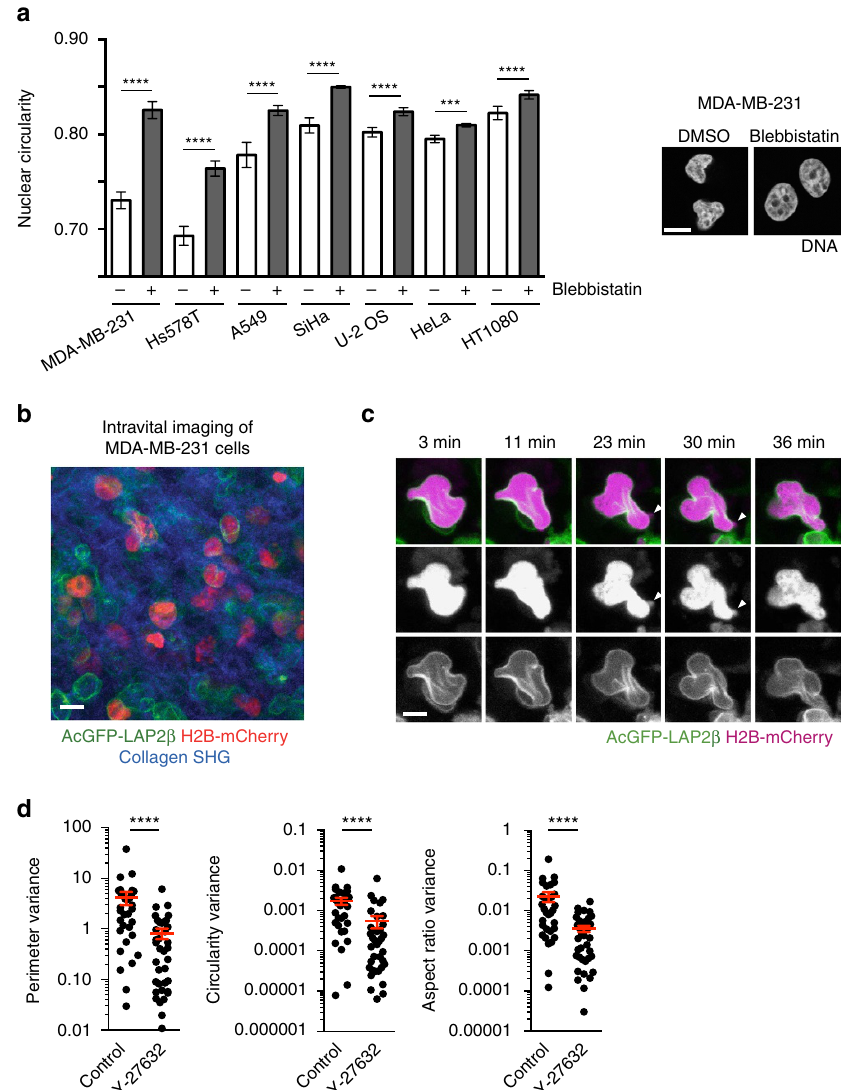
Figure 5 | Actomyosin contractility is a determinant of nuclear shape and dynamics. ( a ) Cancer cell lines derived from different tissues were treated with 5 m M blebbistatin for 24h, fixed and stained with DAPI. Quantification of nuclear circularity (left panel) and representative images of the breast cancer cells line MDA-MB-231 (right panel) are shown. Error bars, s.d. of three independent experiments ( n 4 100 nuclei each). Scale bar, 10 m m. ( b ) Intravital imaging of an MDA-MB-231 xenograft tumour expressing AcGFP-LAP2 b and H2B-mCherry. Collagen is shown in blue. Scale bar, 20 m m. ( c ) Intravital time-lapse series of an MDA-MB-231 tumour expressing AcGFP-LAP2 b and H2B-mCherry. The arrowheads indicate a potential nuclear envelope rupture event. Images represent fields of 30 m m (cid:3) 30 m m. Scale bar, 10 m m. ( d ) Quantification of nuclear perimeter, circularity and aspect ratio variance over time from intravital MDA-MB-231 imaging movies ( c ). Variance values for individual cells of control and Y-27632-treated tumours are plotted (control; n ¼ 32, Y-27632; n ¼ 37 cells each). Graph shows *** P ¼ 0.0002, **** P o 0.0001 (unpaired t